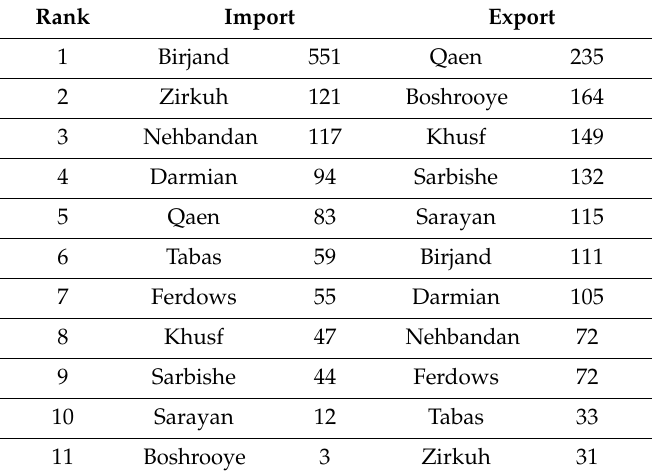
Table 3. Ranking the counties in virtual water import and export (Mm 3 /